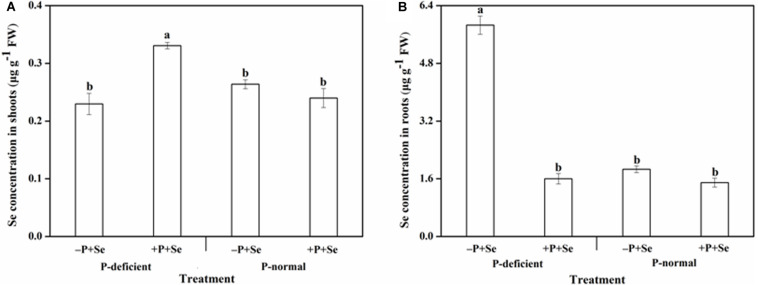
Se concentration in (A) shoots and (B) roots of rice seedlings under different treatments. Data are presented as means ± SEs (n = 3). Different letters indicate statistically significant differences among the treatments at P < 0.05 according to Duncan’s test.